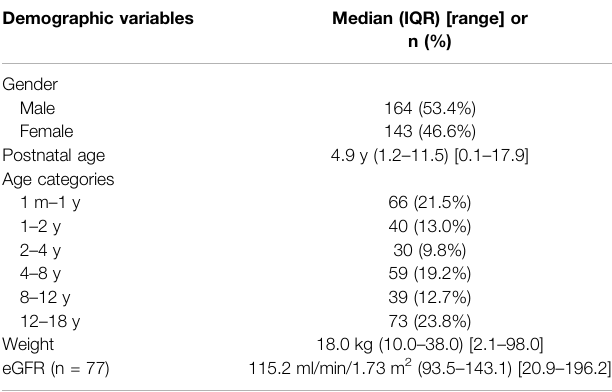
TABLE 2 | Demographic and clinical characteristics of the Radboudumc PICU- dataset from 2018 (n (cid:1) 307). Demographic